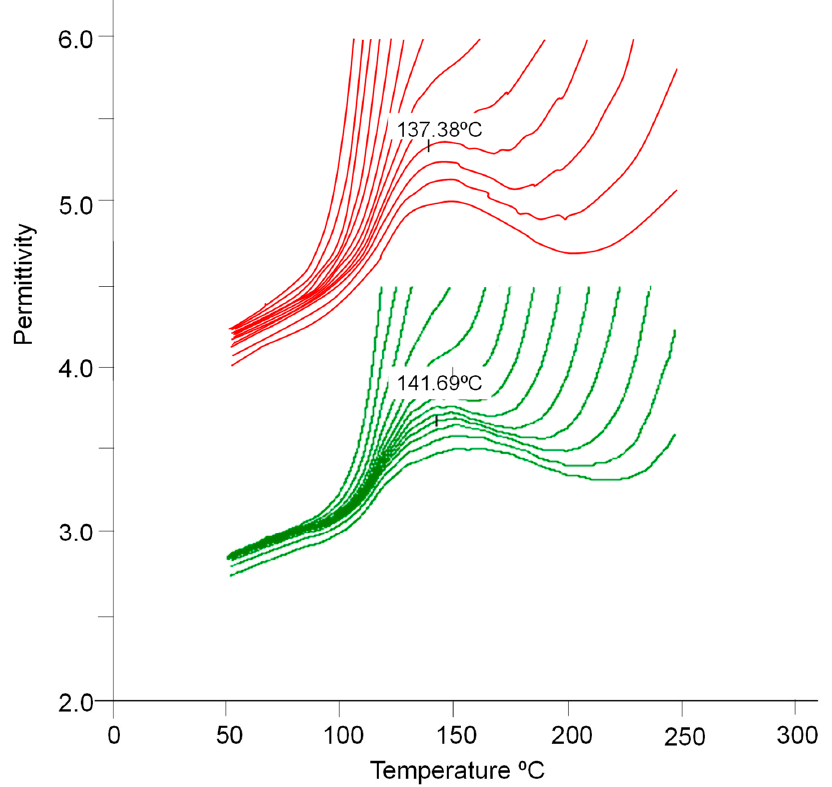
Figure 9. Permittivity ε (cid:48) vs. temperature at various applied frequencies for the system Figure 9. Permi tt ivity ε ’ vs. temperature at various applied frequencies for the system DGEBA/mXDA without (green lines) and with AuNPs (8.5%) (red lines). DGEBA/mXDA without (green lines) and with AuNPs (8.5%) (red lines). Table 8. Glass transition temperature T g , permi tt ivity ε ′ , loss factor ε ″ , dissipation tan δ , and conduc- tivity (pmho/cm) for the system DGEBA/mXDA without and with AuNPs (8.5%). All of them are at 1 kHz, except T g .